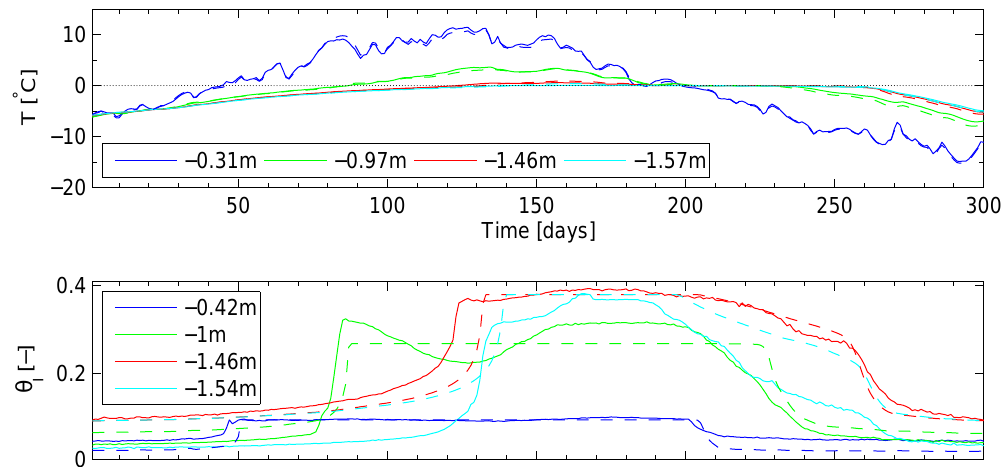
Fig. 8. Measured (solid) and simulated (dashed) temperature and liquid water content for the conduction scenario (iii) of the Tianshuihai simulation. The data show the period from 25 March 2008 to 19 January 2009.